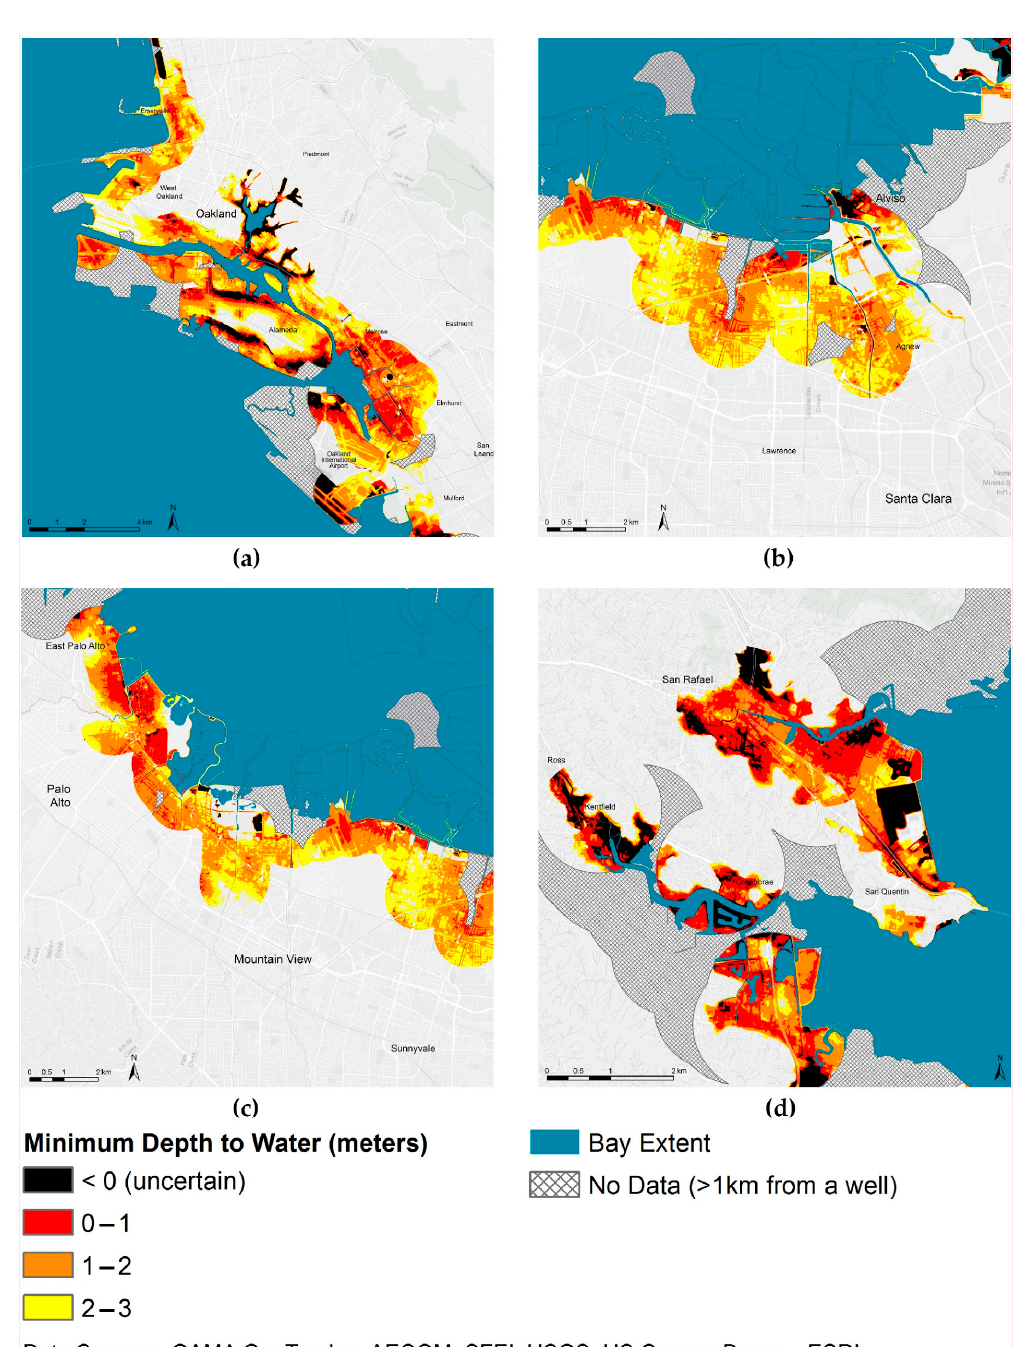
Figure 5. Maps of minimum depth-to-water in selected areas. ( a ) Shallow groundwater conditions were widespread in the Oakland area, including in some low-lying neighborhoods not directly connected to San Francisco Bay. ( b ) Alviso already experiences groundwater flooding during storms and this flooding will worsen as the sea level rises. The depth-to-water model was likely conservative in this area due to pumping, which results in artificially high depth-to-water values around a landfill. ( c ) Much of the Silicon Valley coastline had very shallow groundwater, threatening significant properties such as Google’s headquarters. The areas along the shoreline with depth-to-water over 3 m are actively-pumped landfills. ( d ) Even in Marin County, where the coastline is dominated by steep blu ff s, some low-lying coastal flatlands built on fill material were at risk of emergence due to a high groundwater